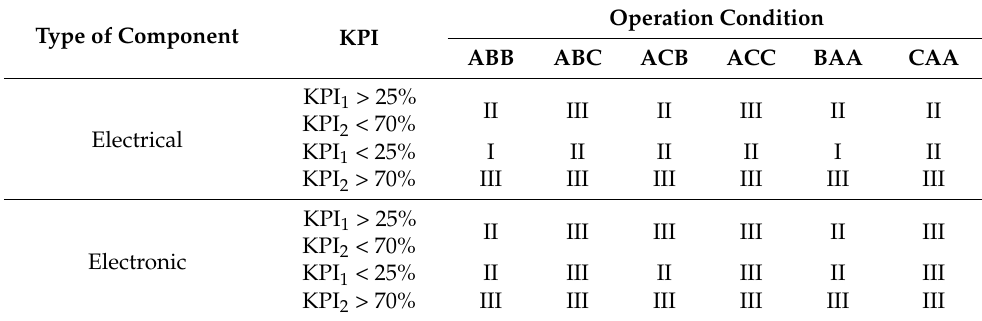
Table 14. N-dimensional matrix for preventive maintenance selection in